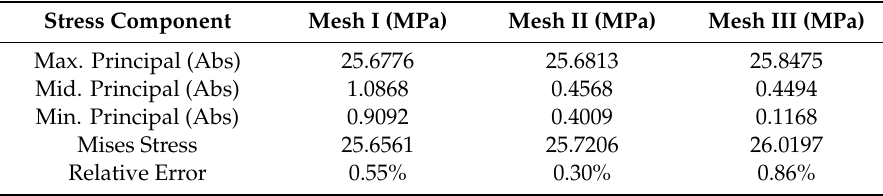
Table 7. Stress statistics and relative error for di ff erent meshes on